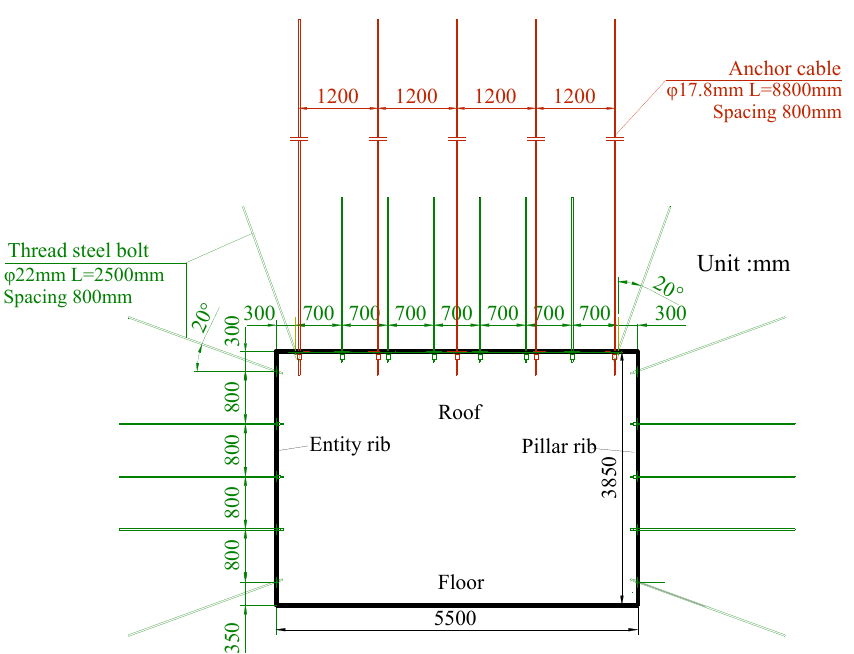
Figure 4. Sections of main support of AR 4106.